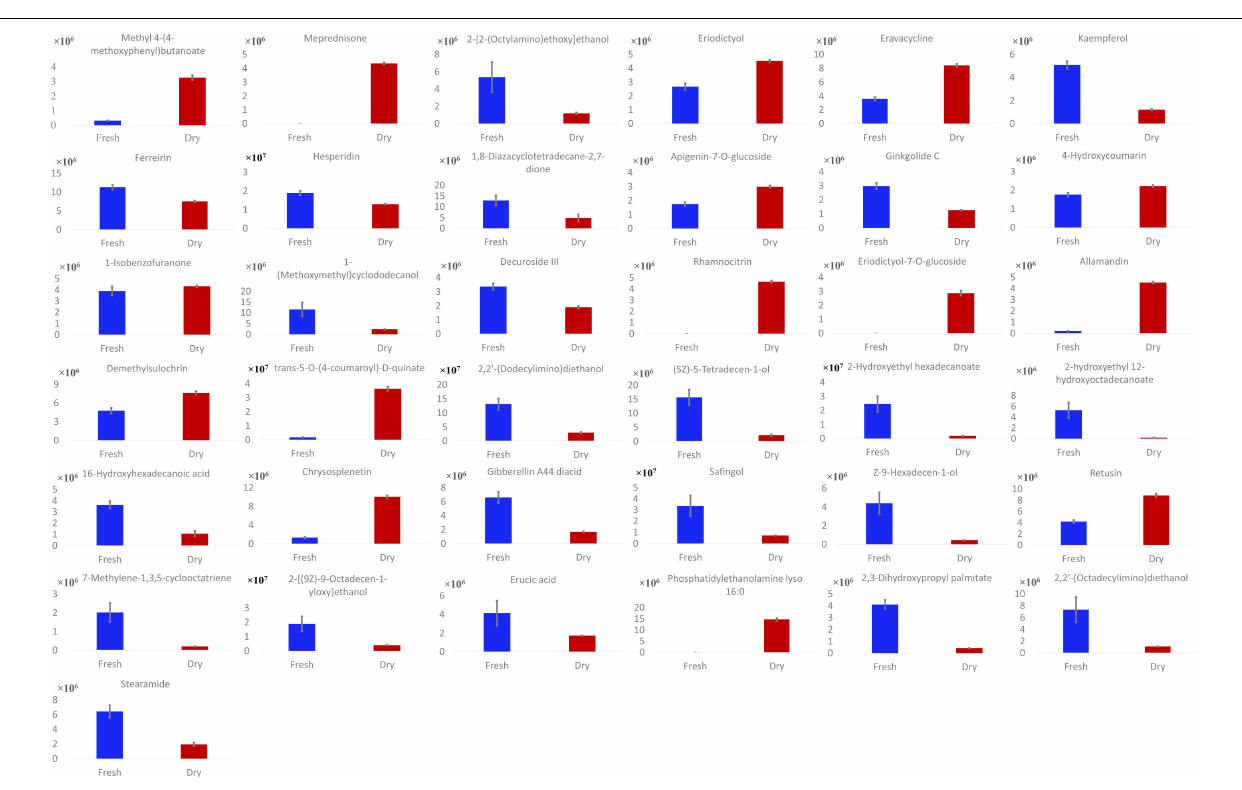
FIGURE 2 | Quantification of compounds in dried and fresh